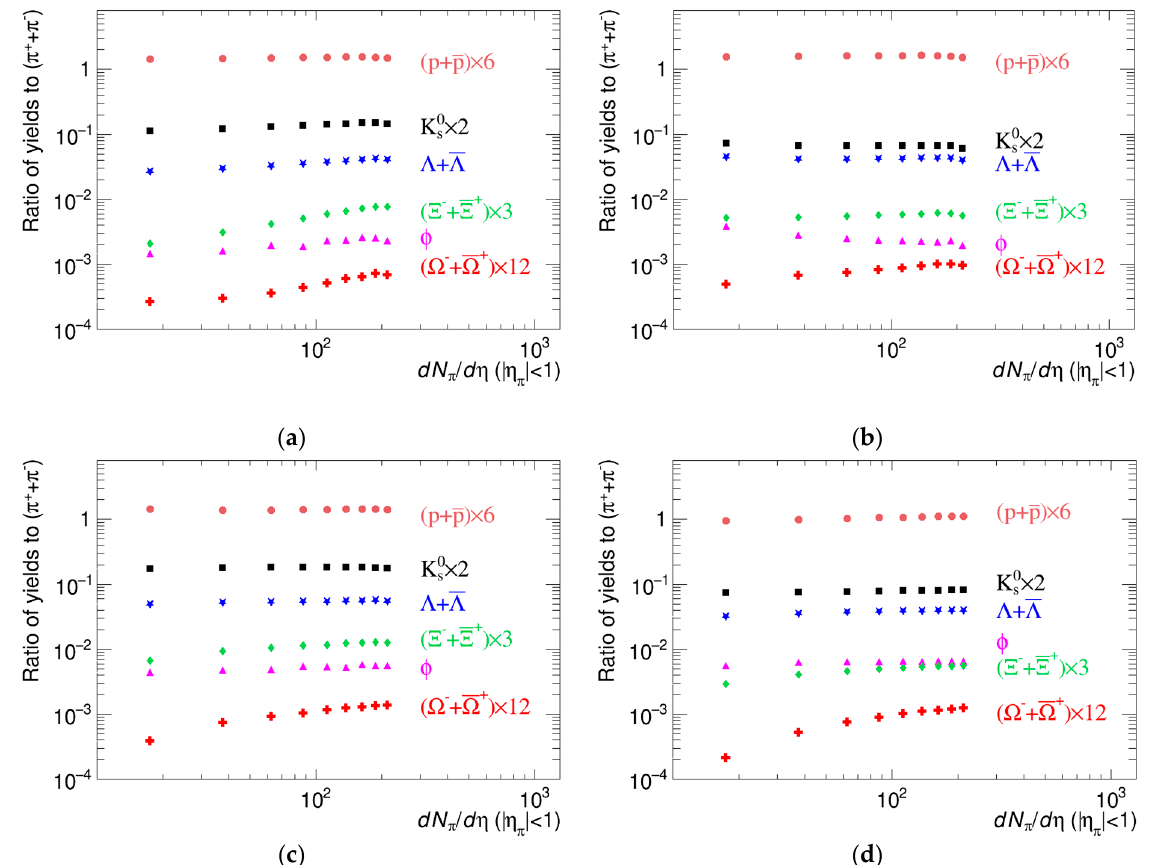
Figure 4. Ratios p/ π , 𝐾 𝑠0 / π , ϕ (1020)/ π , Λ / π , Ξ / π and Ω / π as a function of the final state charged particle multiplicity in Au+Au collisions at √𝑠 (cid:3015)(cid:3015) = 7.7 GeV as predicted by UrQMD [11] ( a ), AMPT [13] ( b ), PHSD [12] ( c ) and EPOS 1.99 [14] ( d ) event generators.